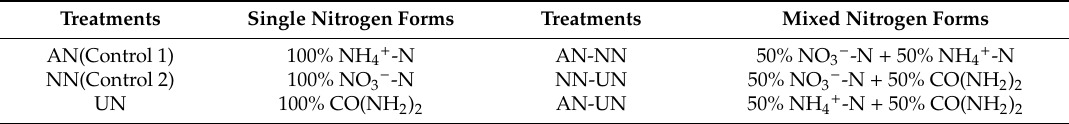
Table 1. The composition of nitrogen treatments in terms of di ff erent nitrogen